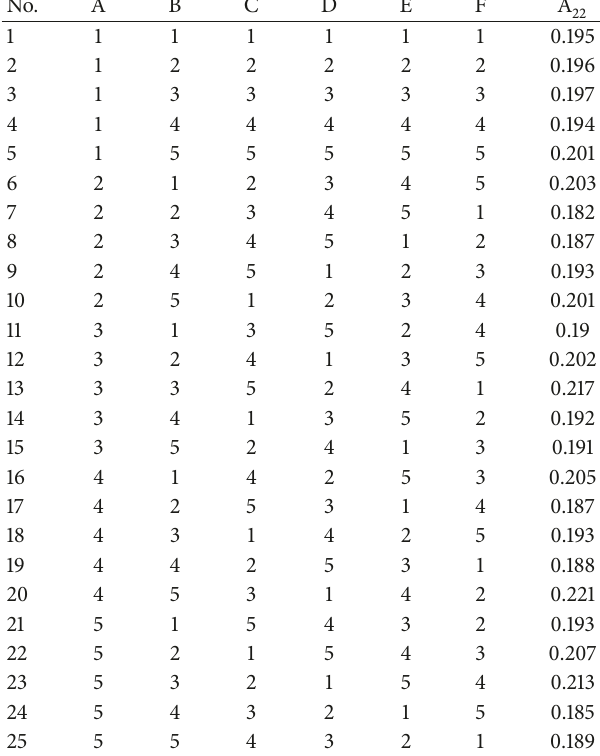
Table 3: Orthogonal experimental arrangement and results of